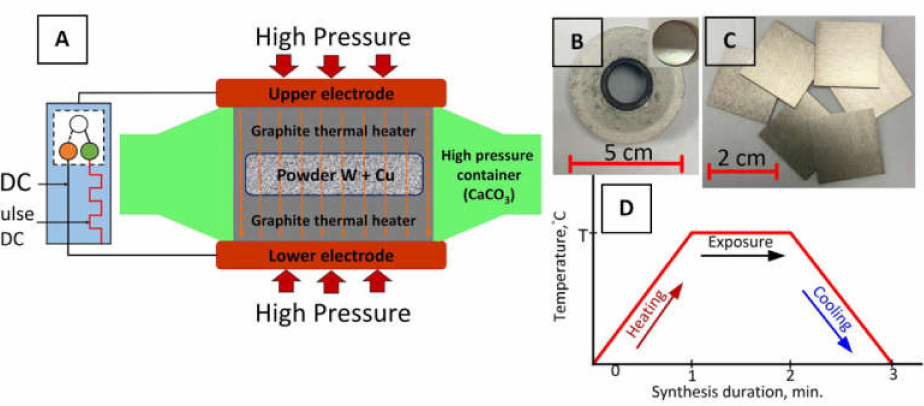
Figure 1. Schematic view of the isostatic hot pressing ( A ), sample preparation container with graphite heating element and W–Cu samples (insert) ( B ), radiation shields based on W–Cu composite with a 2.0 × 2.0 cm 2 size and different thicknesses ( C ), and a schematic view of the sintering process ( D ). Initially, the W–Cu samples were fabricated in the form of tablets with a diameter of 2.6 cm and a thickness of 0.3 cm. Further, by mechanical processing, square samples with a 2.0 × 2.0 cm 2 size were formed. Two types of samples were made: the first, six samples with a 0.27 ± 0.05 cm thickness for the investigation of the sintering process influence on the W–Cu structure, microstructure parameters, chemical composition, and density (effective and relative); the second, five samples prepared using optimized technology with 0.06, 0.09, 0.12, 0.15, and 0.27 ± 0.05 cm thicknesses for shielding properties measurements.